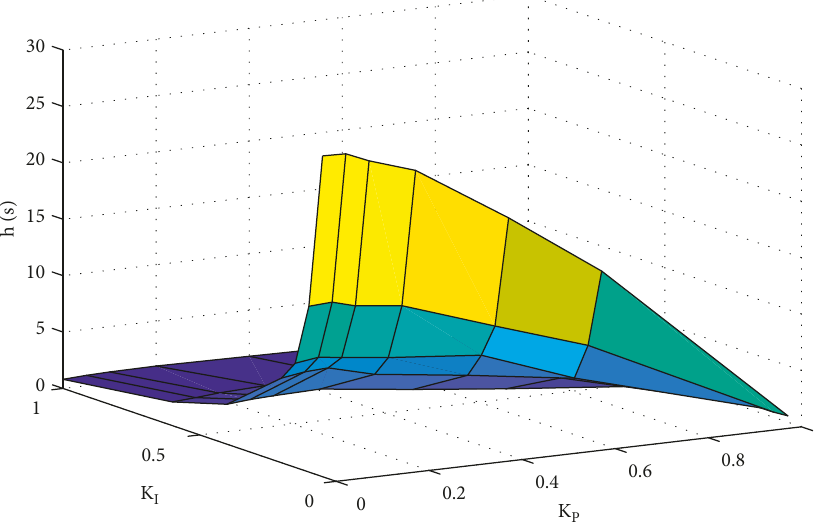
Figure 7: h ∝ ( K Table 9: Delay margin h ∝ ( K